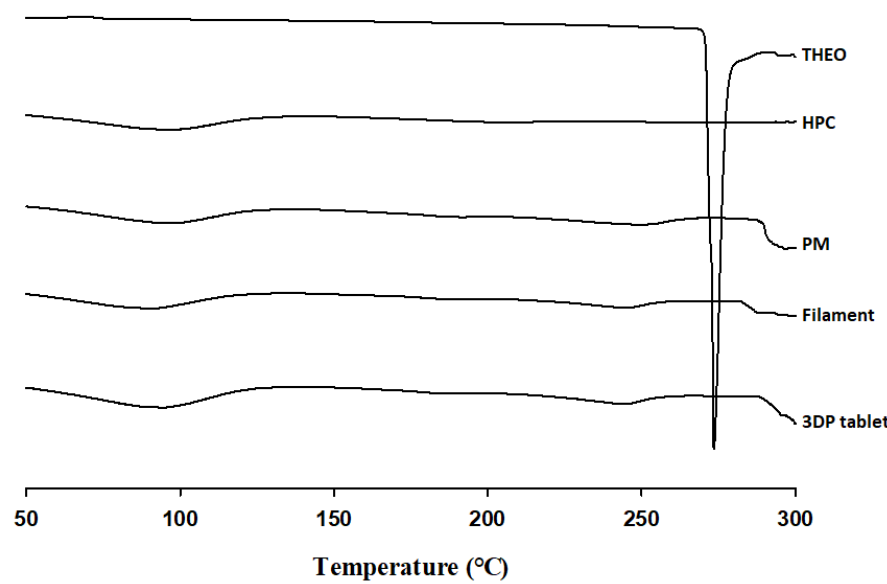
Figure 3. DSC curves of free THEO, hydroxypropyl cellulose (HPC), physical mixture (PM), THEO-HPC filament, and 3DP tablet. PM represents the physical mixture of THEO, HPC, and stearic acid (SA) at a 30:70:7 ( w / w / w ) ratio.